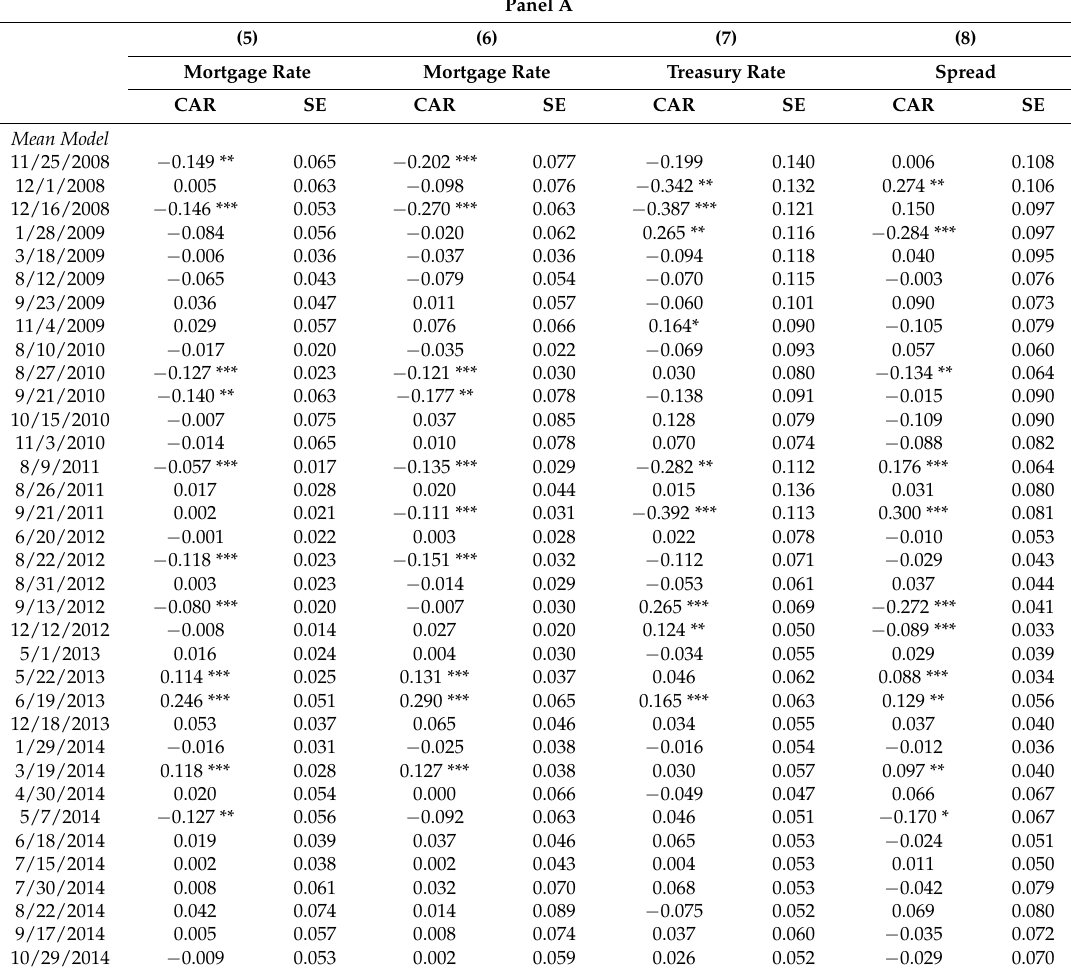
Table 2. Cumulative abnormal returns (CARs) in 3-day windows. We run four regressions (Equations (5) to (8)) with 3-day event window (i.e., t = − 1, 0, 1). For each regression, the CARs and standard errors (SEs) on QE event days are reported in Panel A. Coefficient estimates and SEs of control variables and GARCH components are reported in Panel